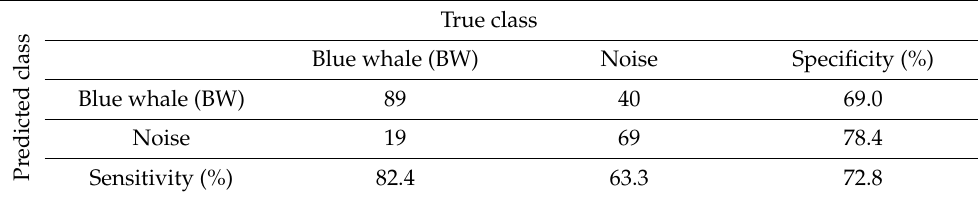
Table 6. The confusion matrix associated with the comparison method I for the ‘Blue whale (BW) + Noise’ dataset (the accuracy (%) is indicated in bold font and calculated as a ratio of the sum of diagonal values to the sum of all values × 100).